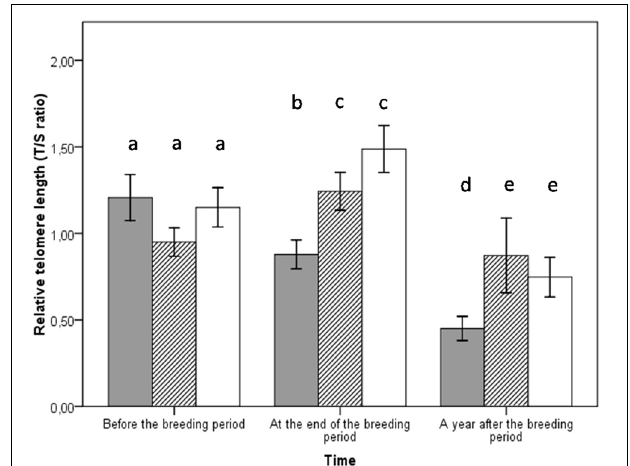
FIGURE 1 | Plasmatic oxidative damage at different time periods: before the breeding event (females n = 25, males n = 25), at the end of the breeding (females n = 25, males n = 25), a year after the breeding event (females n = 10, males n = 17). Bars represent ± SE. Females in gray and males in white.